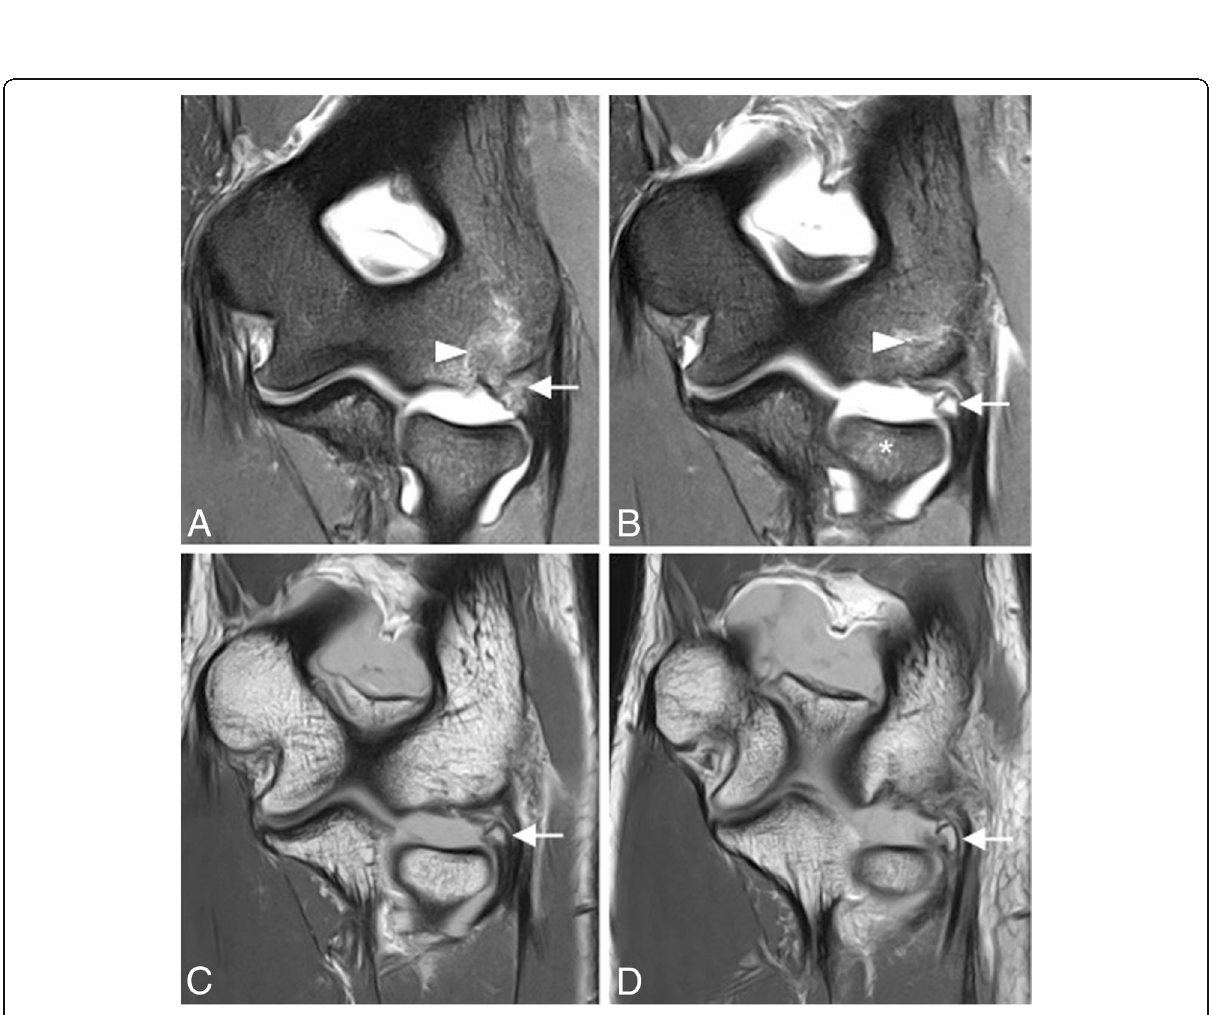
Fig. 23 Posterolateral rotatory instability, stage 1. Coronal FS PD-weighted MRI ( a , b ) and coronal T1-weighted MRI ( c , d ) showing an avulsion of the proximal lateral ulnar collateral ligament and retraction of the osseous fragment (white arrows). Bone marrow edema is seen in the capitellum (white arrowheads) and radial head (white